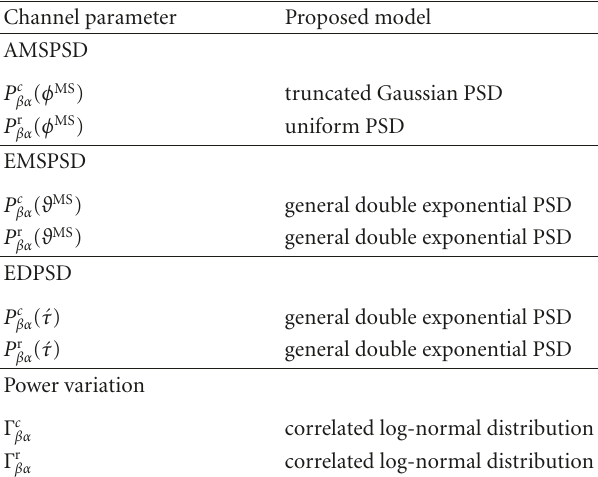
Table 4: Angular-delay PSD